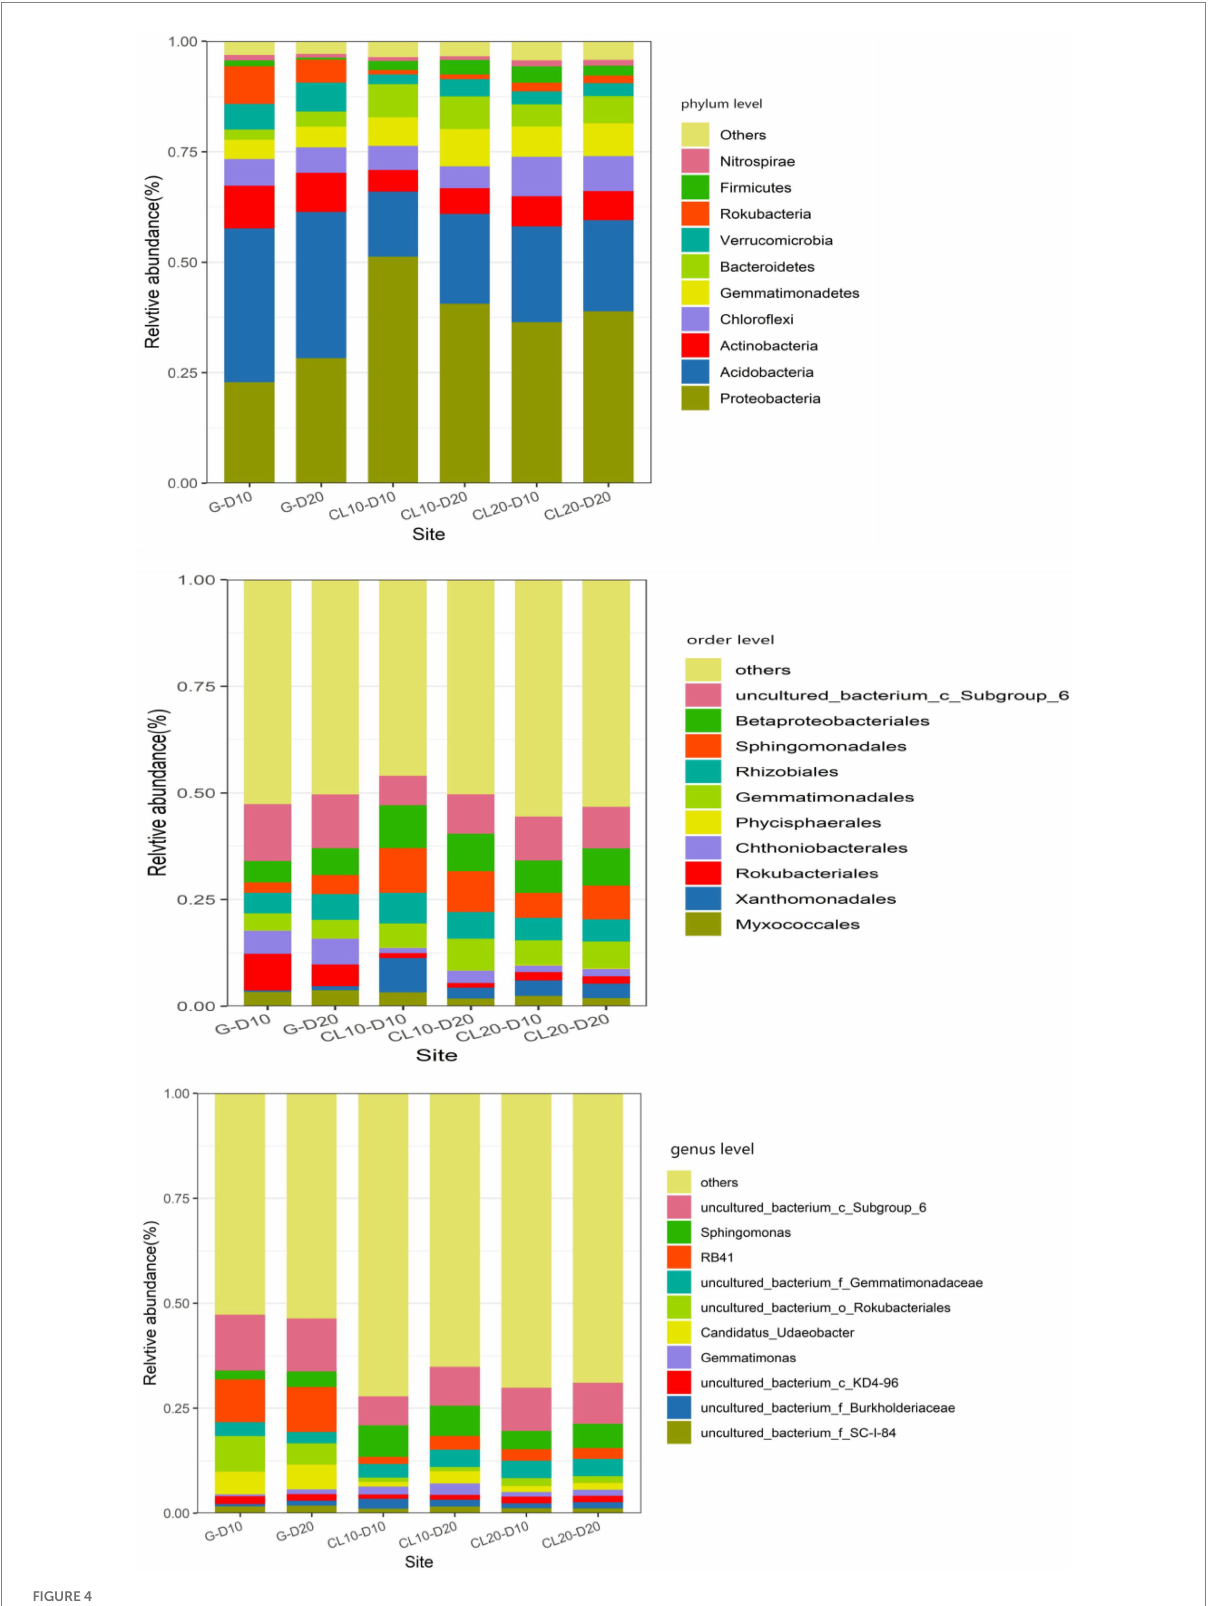
FIGURE 4 Relative abundance of dominant species in phylum, order and genus level under different land use types and